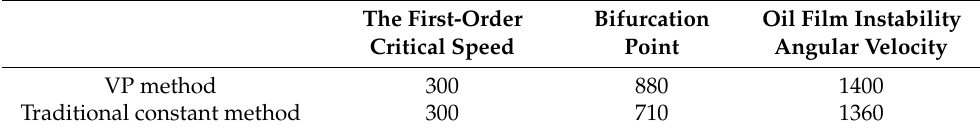
Table 2. Comparison of the results of the VP method and the traditional method (Unit: rad/s).